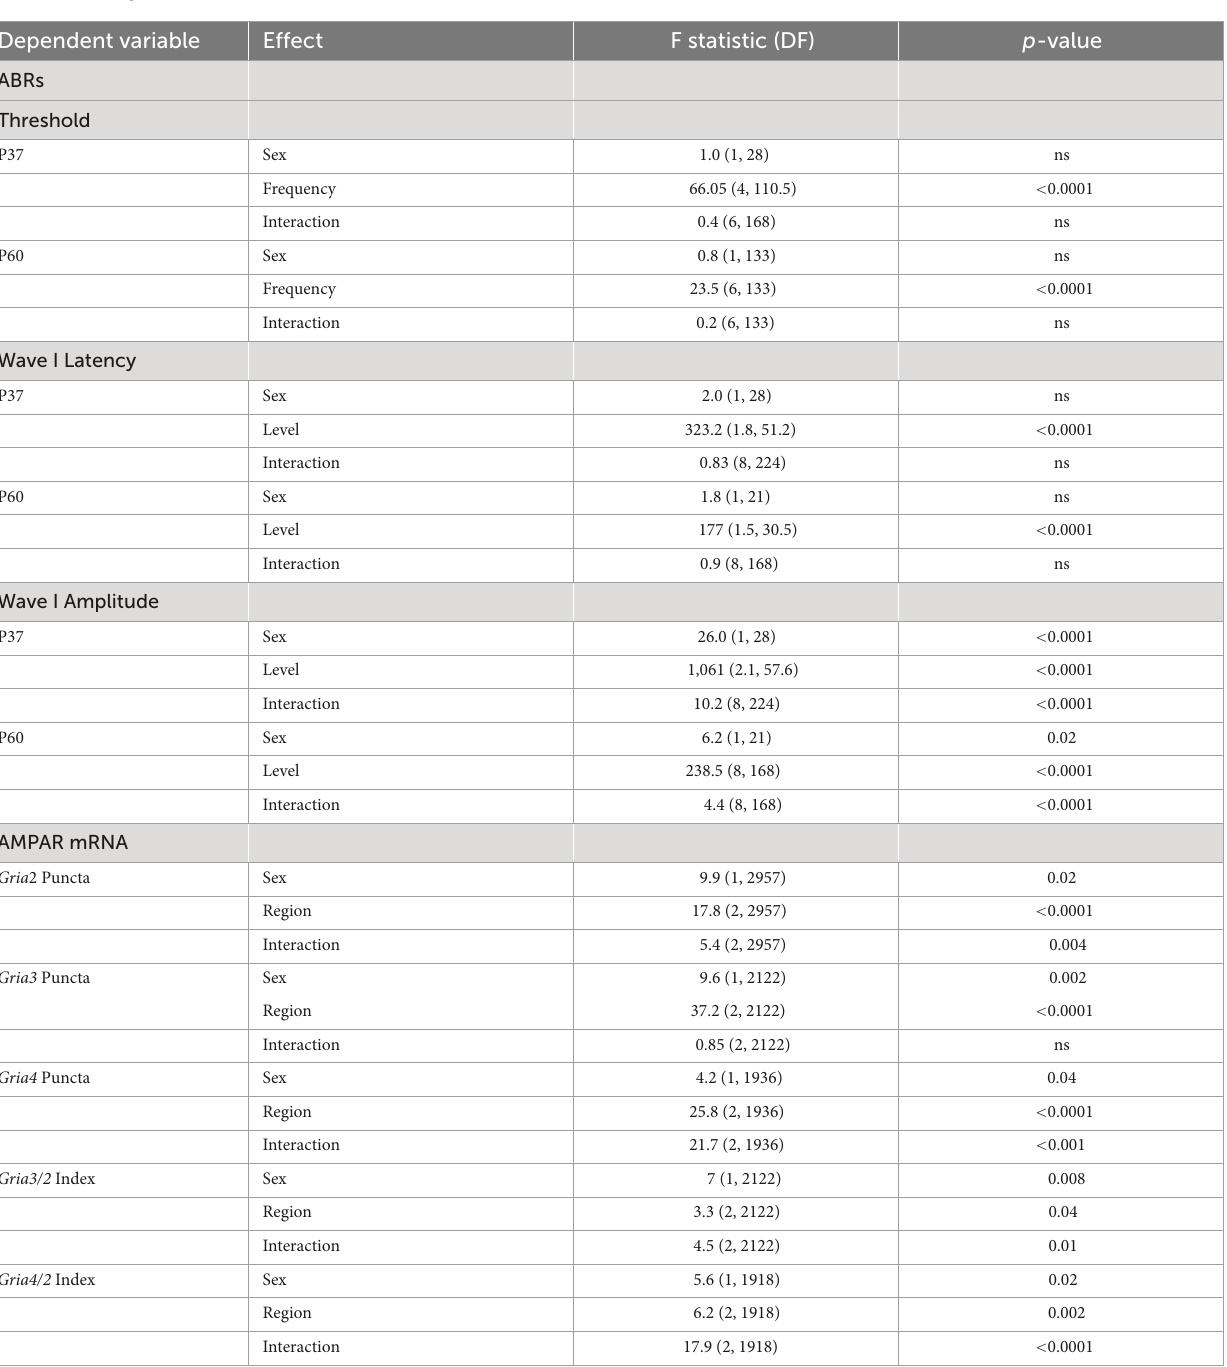
TABLE 1 Summary of ANOVA